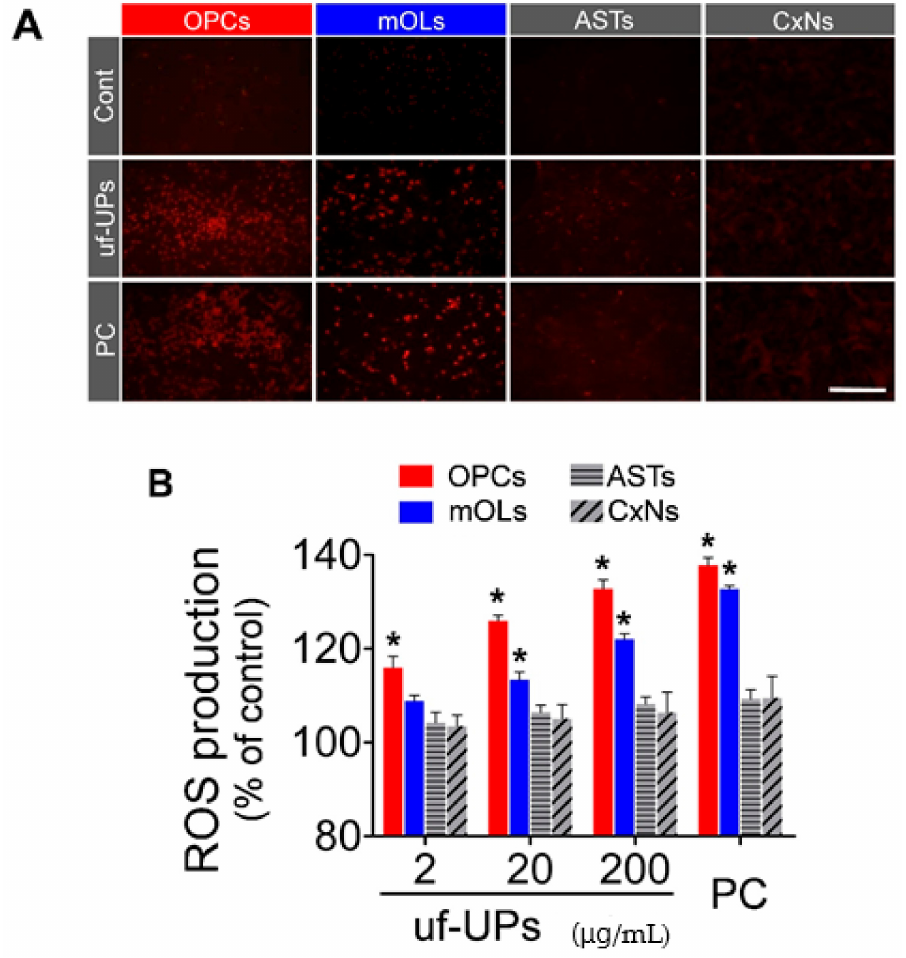
Figure 4. Reactive oxygen species (ROS) production analysis using DHE staining and DCF assays. ( A ) DHE staining. Large amounts of ROS are produced in OPCs and mOLs after uf-UP exposure (200 µ g/mL). ( B ) DCF assay. The amounts of ROS produced by OPCs and mOLs are significantly higher the ROS levels produced by ASTs and CxNs after exposure to more than 2 and 20 µ g/mL uf-UPs, respectively. Hydrogen peroxide (H 2 O 2 , 100 µ m) is used as a positive control (PC). Note that ROS production in each cell type at 200 µ g/mL uf-UPs is similar to the ROS production level at 100 µ m hydrogen peroxide. Data are expressed as percentage of the control and represent mean ± SEM ( n = 8). * p < 0.05 vs. ASTs and CxNs. Scale bar = 200 µ